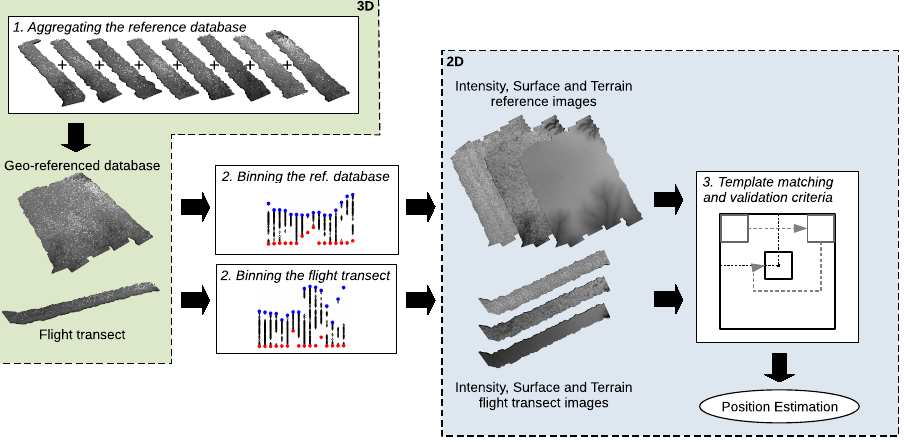
Figure 4. General overview of the methodology. White squares indicate processing on data until the position estimation is made. 3D point cloud domain is enclosed in green background while 2D matrix domain is enclosed in blue